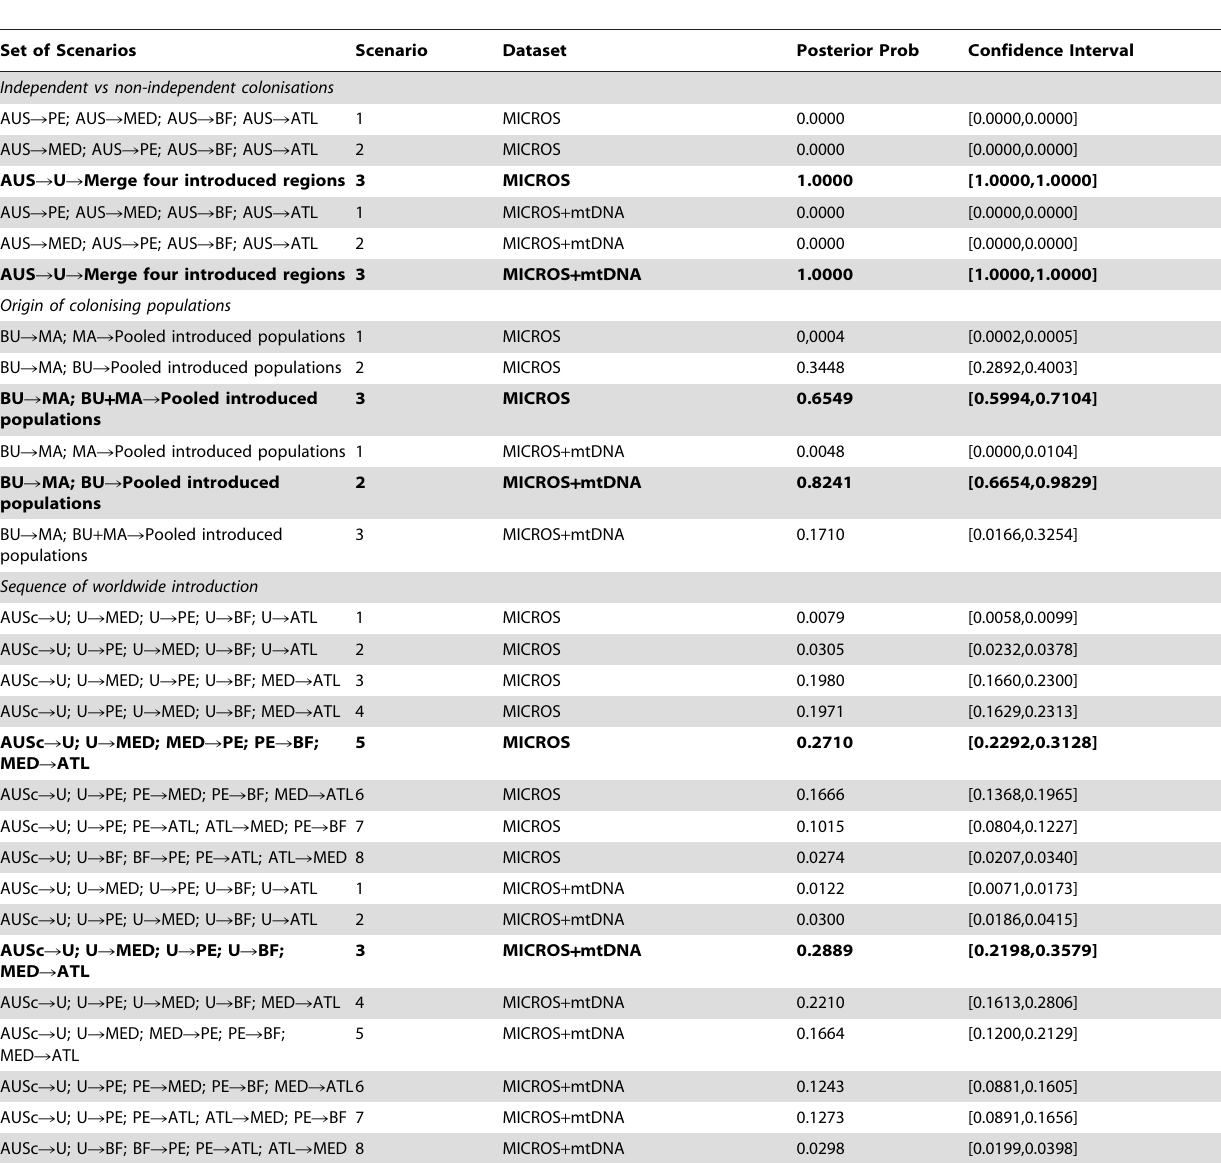
Table 3. Posterior probabilities and 95% confidence interval of the competing scenarios of each set of scenarios using approximate Bayesian computation